Question: Does the figure show an increasing or a decreasing trend?
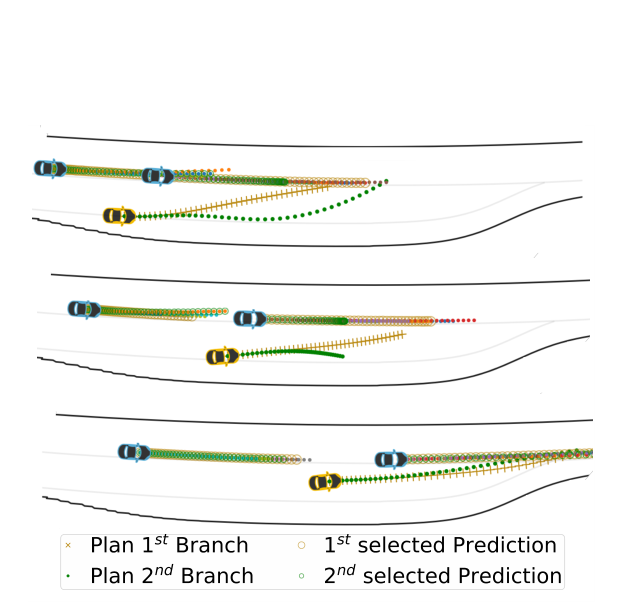
Answer: decreasing